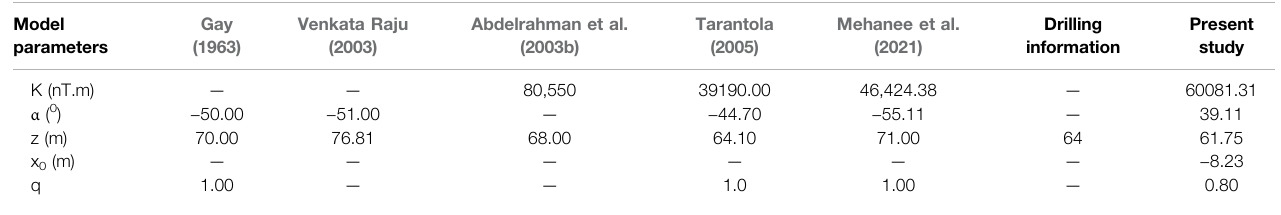
TABLE 7 | Comparative analysis of parameter results for the Pima copper mine anomaly. Model